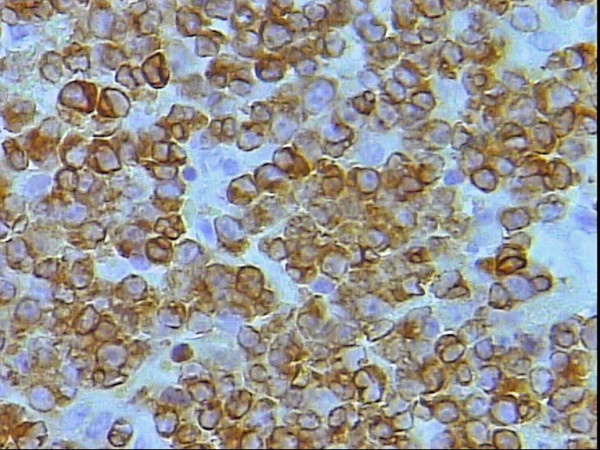
CD79a membranous staining of the lymphocytes, DAB, Hx, × 40.